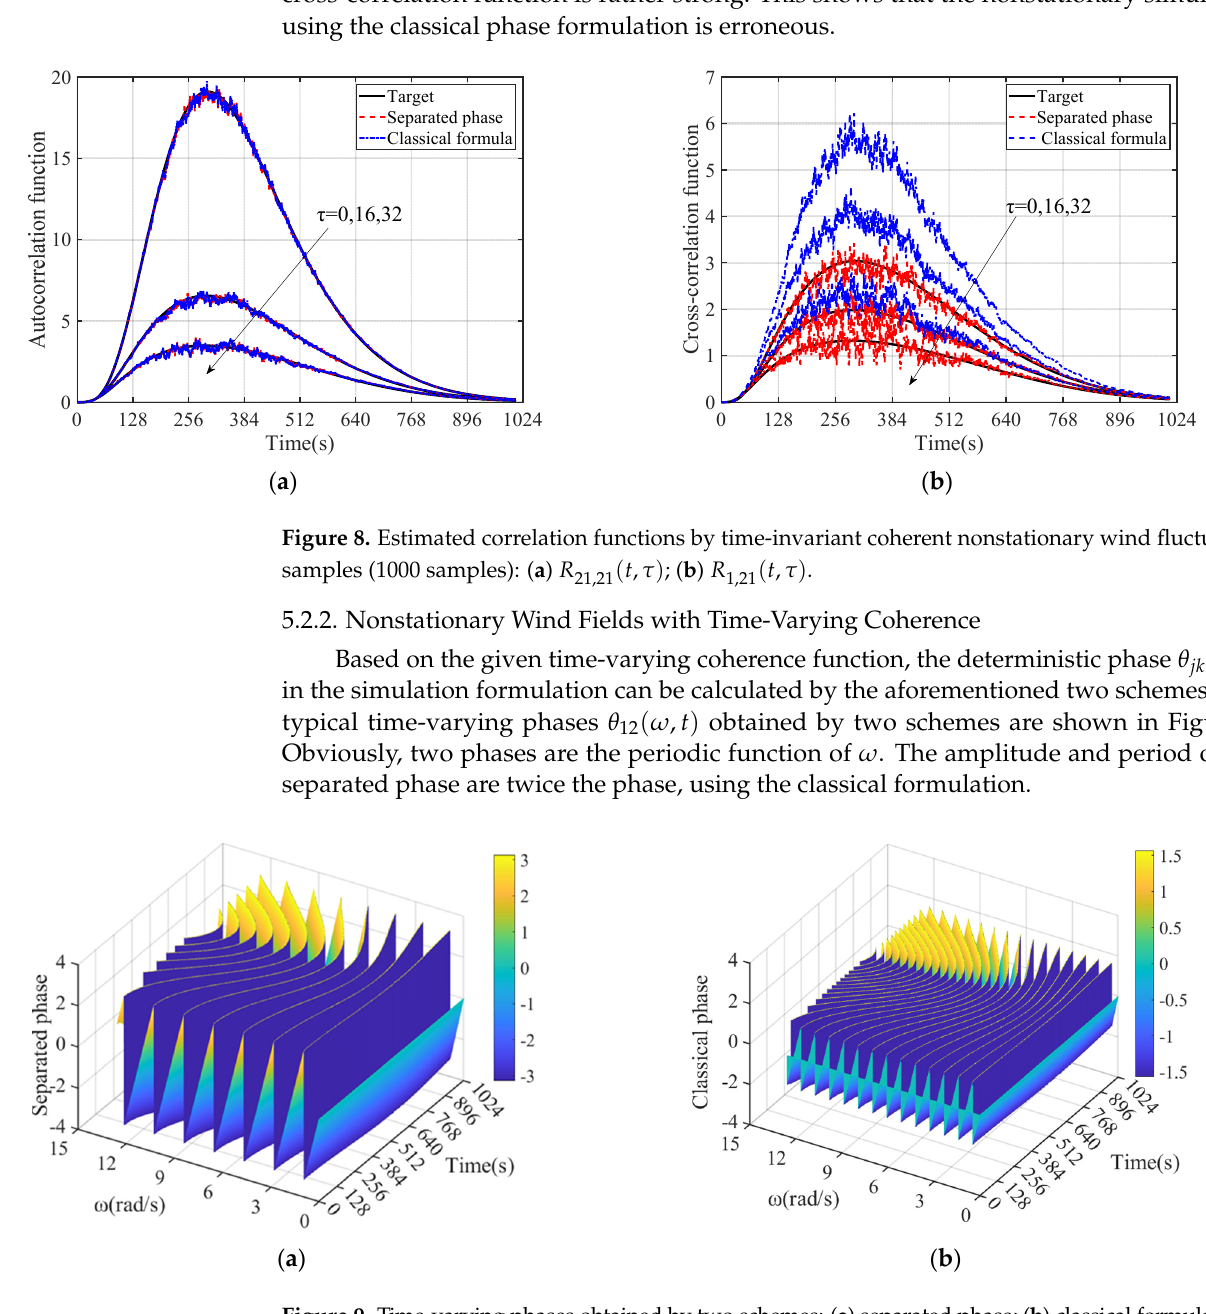
Figure 7. Simulated time-invariant coherent nonstationary wind fluctuation samples: ( a ) Point 1; ( b ) Point 21; ( c ) Point 41.